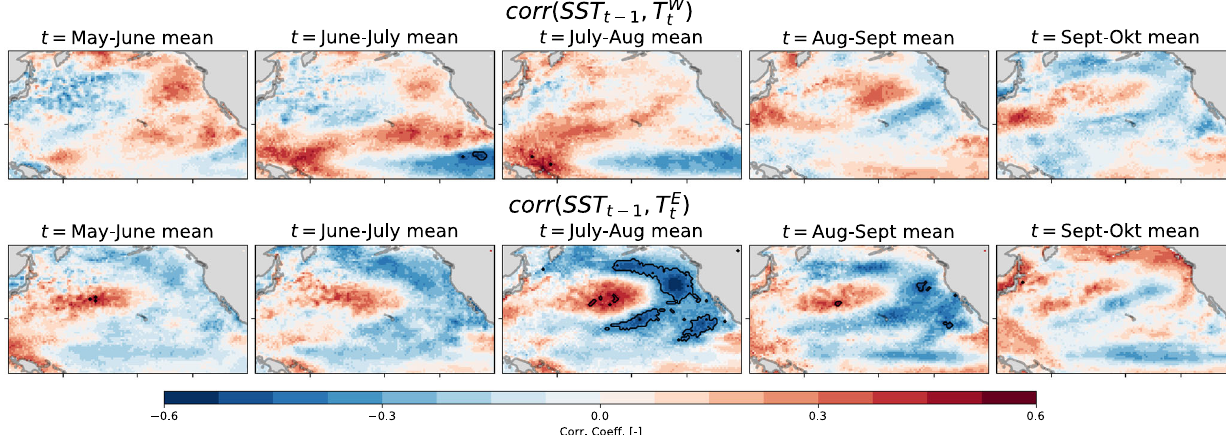
Fig. 5 Correlation maps of SST at lag 1 versus western ( T W ) and eastern ( T E ) US temperature as function of target months, using 2-month mean data. Contour lines indicate signi fi cantly ( α FDR = 0.05) correlating gridcells in 9/10 training subsets.